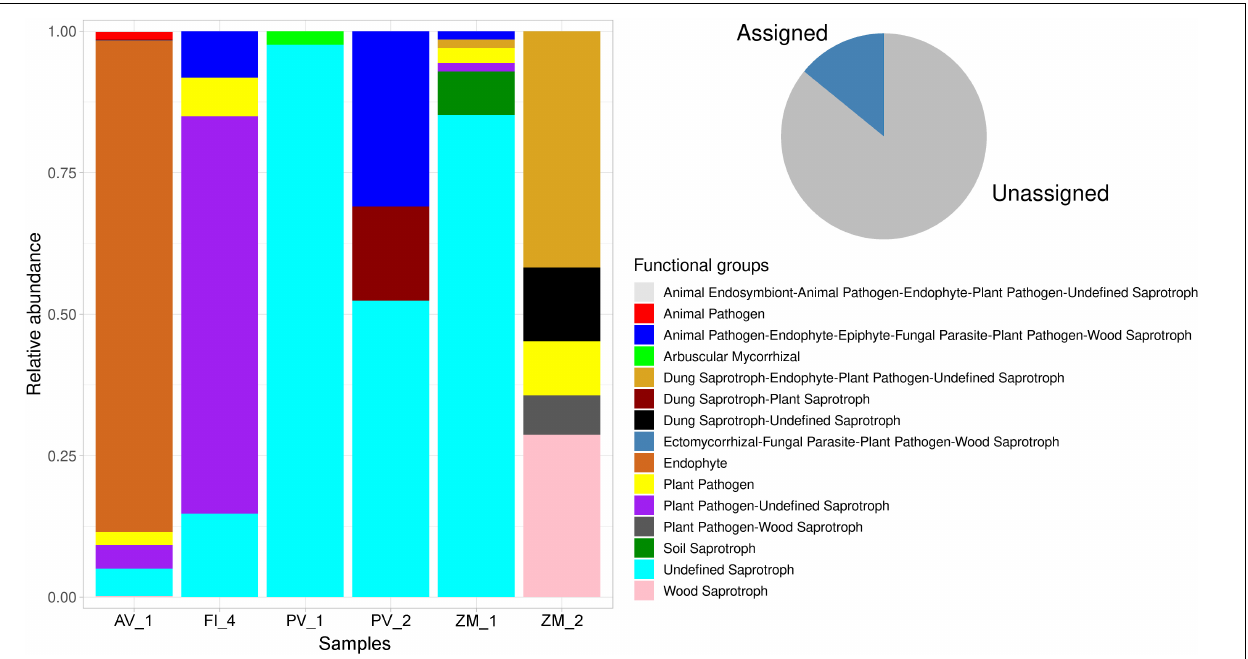
FIGURE 10 | Stacked bar plot showing the relative proportion ( y -axis) of the assigned fungal functional guilds (shown in red in the pie chart) across sediment samples from deep-sea low- and high-temperature hydrothermal vents, and an oxygen minimum zone ( x